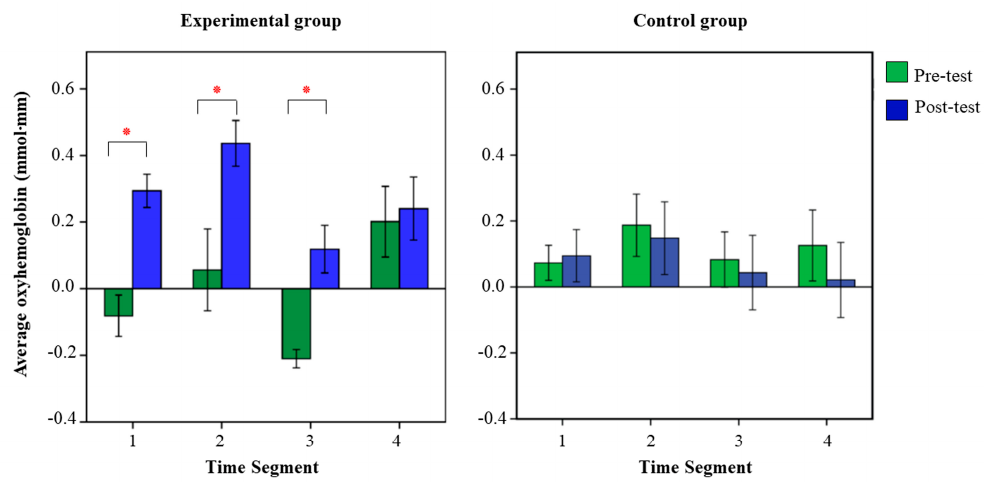
Figure 5. The mean values of oxy-Hb for each of the four 105 s time segments in the 1-back task. To examine these interactions, the experimental group and the control group in oxy-Hb values were analyzed by separate ANOVAs, see Table 5. For the experimental group, both the main effects of time measurement and of time segment were significant, F (1, 7) = 50.54, p < 0.001, η p2 = 0.88, F (3, 21) = 3.98, p < 0.05, η p2 = 0.36. The time measurement and time segment interaction was not significant, F (3, 21) = 2.21, p = 0.12, mainly due to the pre- vs. post-test significant differences for 1st, 2nd, and 3rd time segments, F (1, 7) = 17.27, p < 0.01, η p 2 = 0.71, F (1, 7) = 9.54, p < 0.05, η p 2 = 0.58, F (1, 7) = 18.68, p < 0.01, η p2 = 0.73. Although there was no significant difference between pre- and post-test conditions in mean oxy-Hb values for the 4th time segment, F (1, 7) = 0.12, p = 0.74, the similar trend was reflected in Figure 4. For the control group, in contrast, the main effects of time measurement and of time segment were not significant, F (1, 8) = 0.32, p = 0.58, F (3, 24) = 0.37, p = 0.75, as was the time measurement and time segment interaction, F (3, 24) = 0.19, p = 0.88. Further analyses revealed that there were no significant pre- vs. post-test differences for the four time segments, ps > 0.05. Table 5. The values of oxy-Hb for each of the four 90 s time segments in the 1-back task, M (SD). Time Segments 1